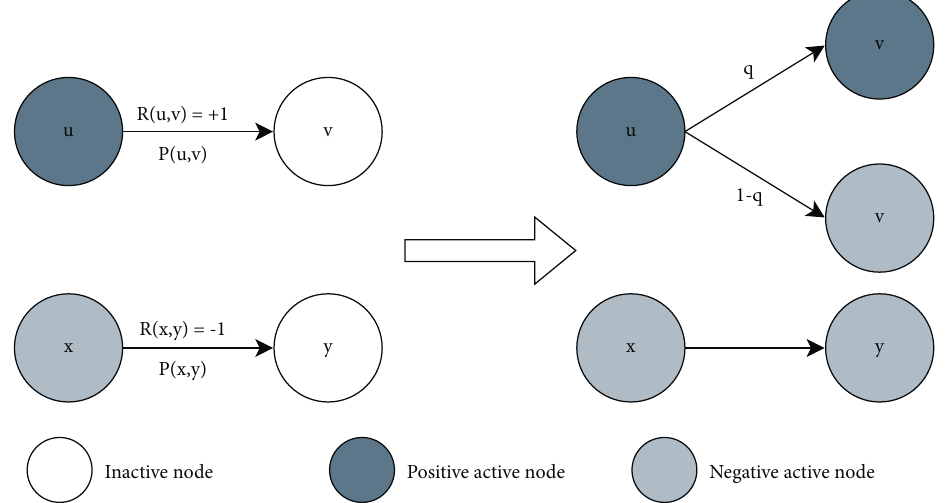
Figure 1: Node state transition diagram in BCLT model.